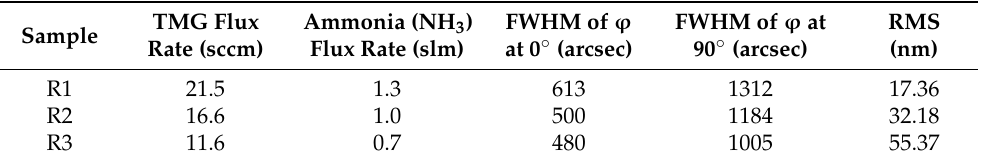
Table 3. Summary of growth parameters variation adapted at higher V/III ratio of 600, HR-XRD on-axis XRC FWHM values along [11 23] and [11 00] directions and 10 × 10 µ m 2 AFM RMS rough- ness